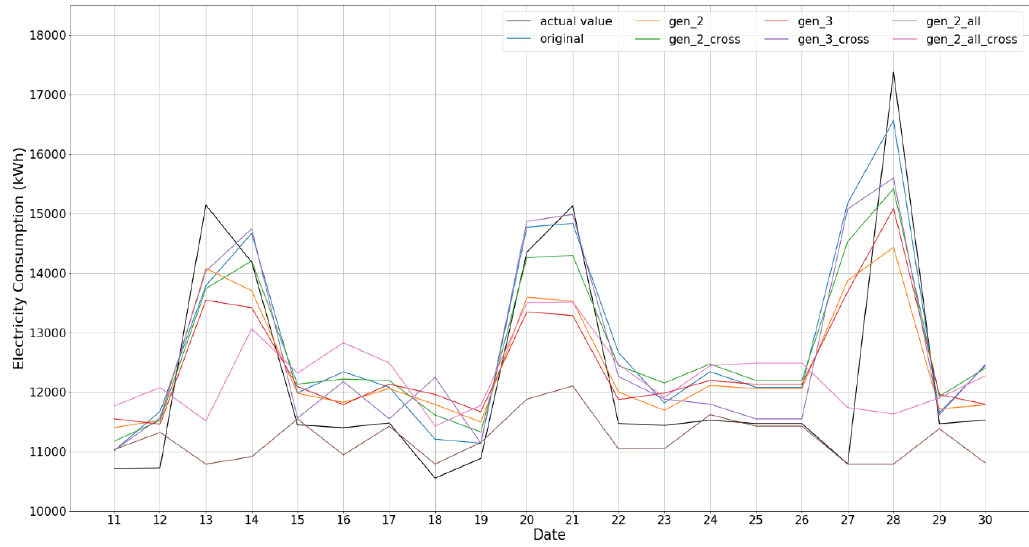
Figure 3. All test results comparison.